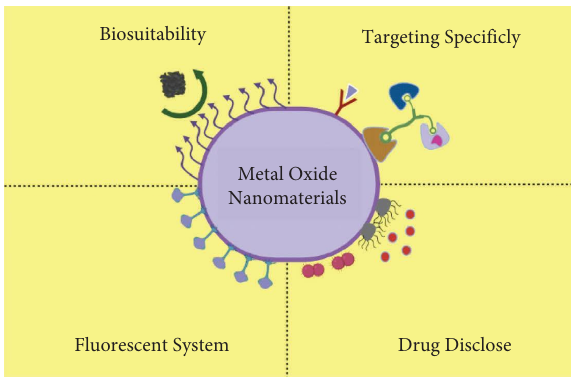
Figure 6: Various use of metal oxide nanoparticles [251].